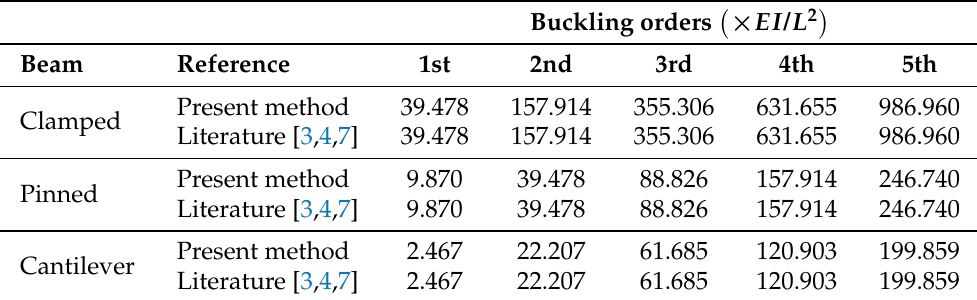
Table 3. Successive buckling orders for clamped, pinned and cantilever beams, and comparison of numerical values between the method proposed on this paper and the cited literature [3,4,7].